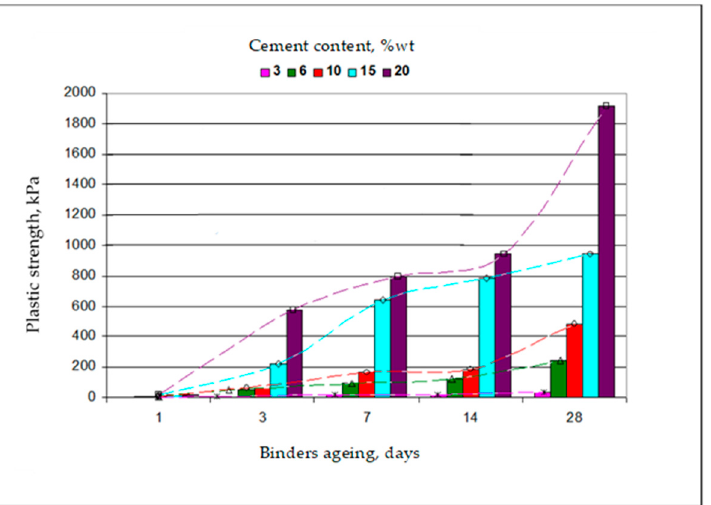
Figure 10. Changes in the plastic strength of specimens with different cement contents with an increasing aging period.